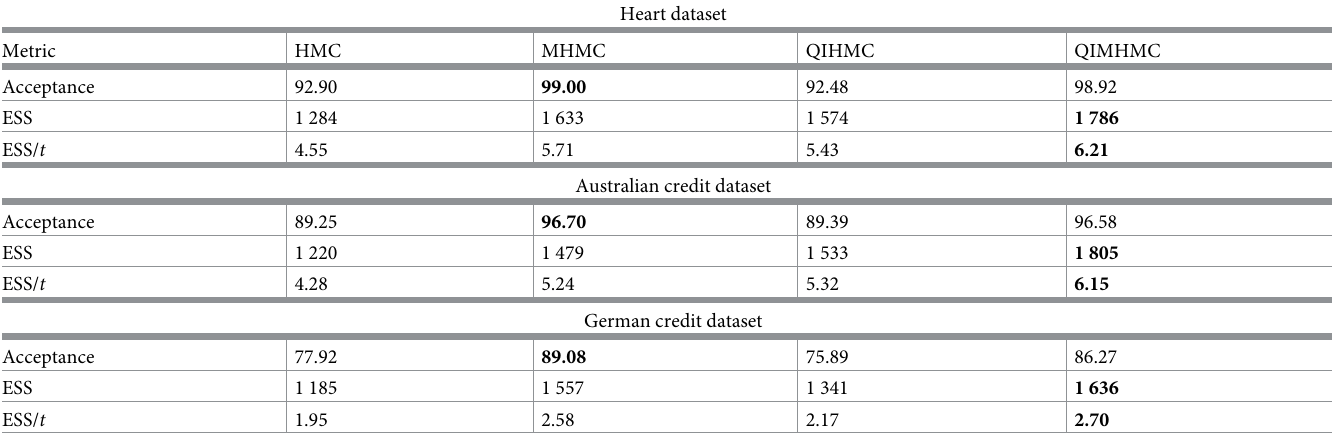
Table 4. Bayesian logistic regression results averaged over 10 runs. The time t is in seconds. The values in bold indicate that the particular method outperforms the other methods on that specific metric.